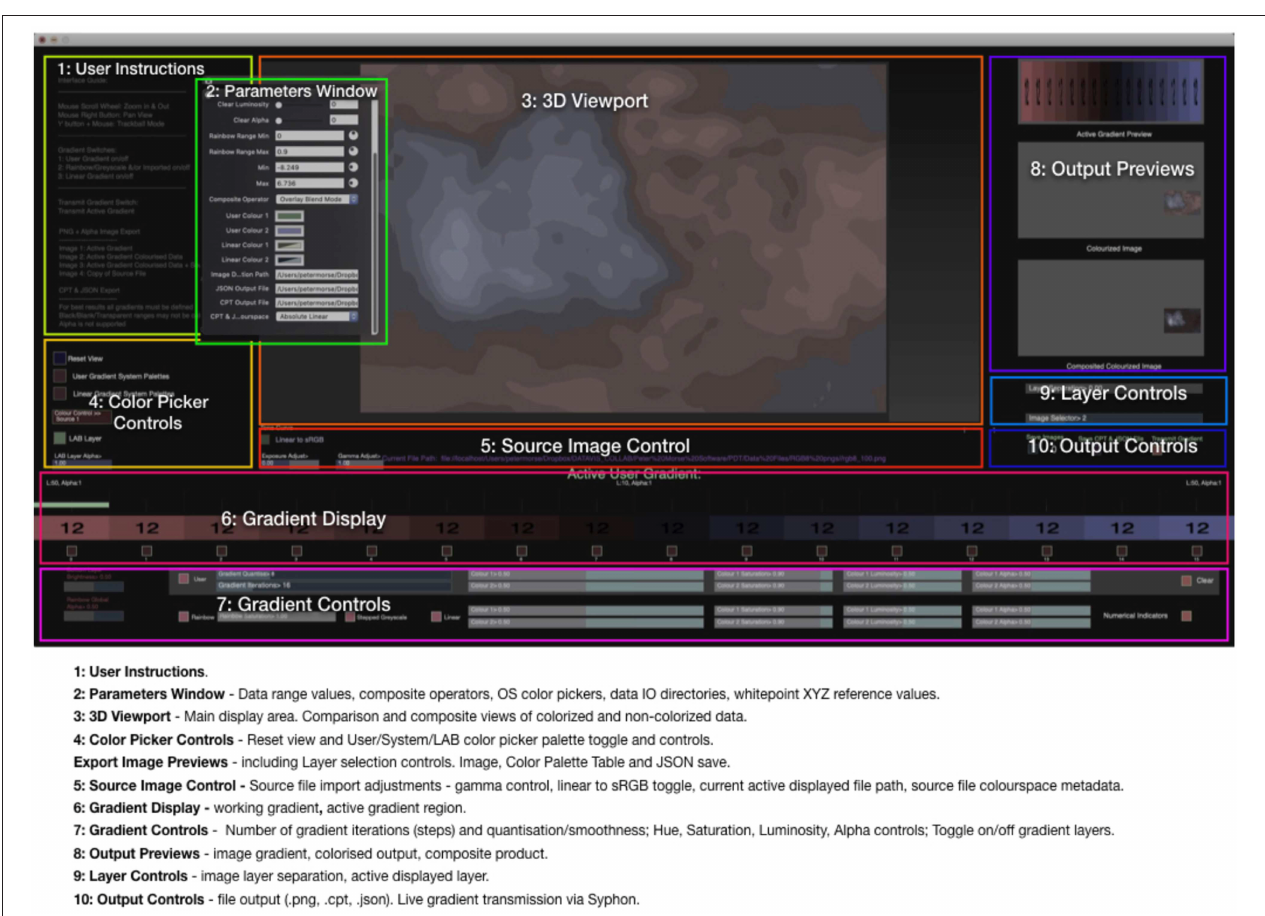
FIGURE 2 | Gradient Designer User Interface. The 10 interface panels are listed in the figure and described in further detail in the